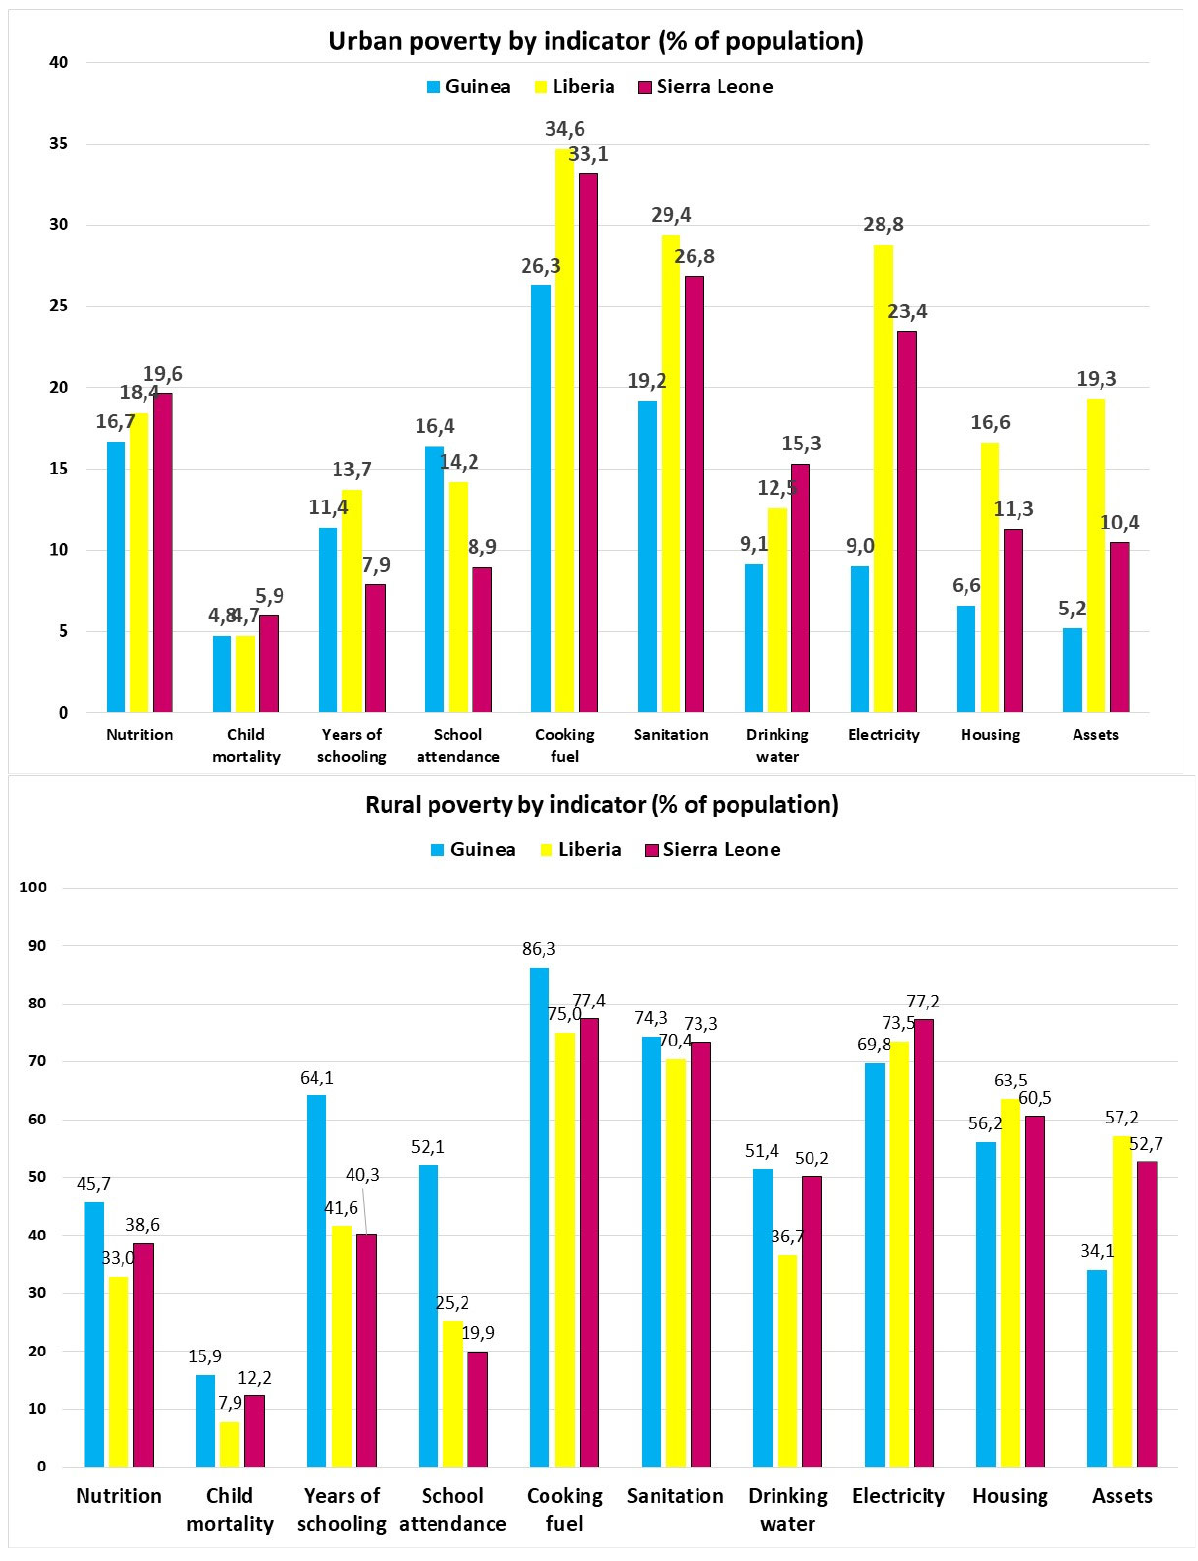
Figure 11. Poverty incidence in rural and urban locations. Source: Authors elaboration based on Alkire et al. (2021) [30].